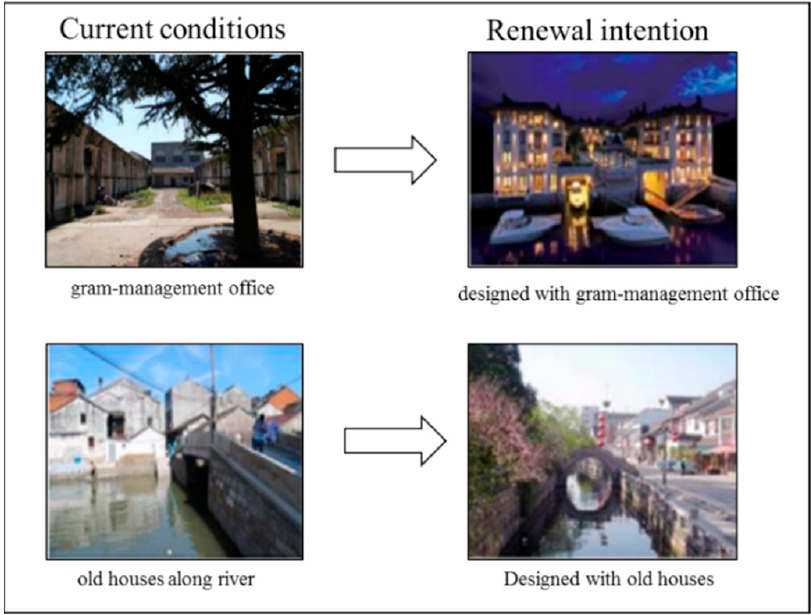
Figure 5. Renewal plan provided by firms.